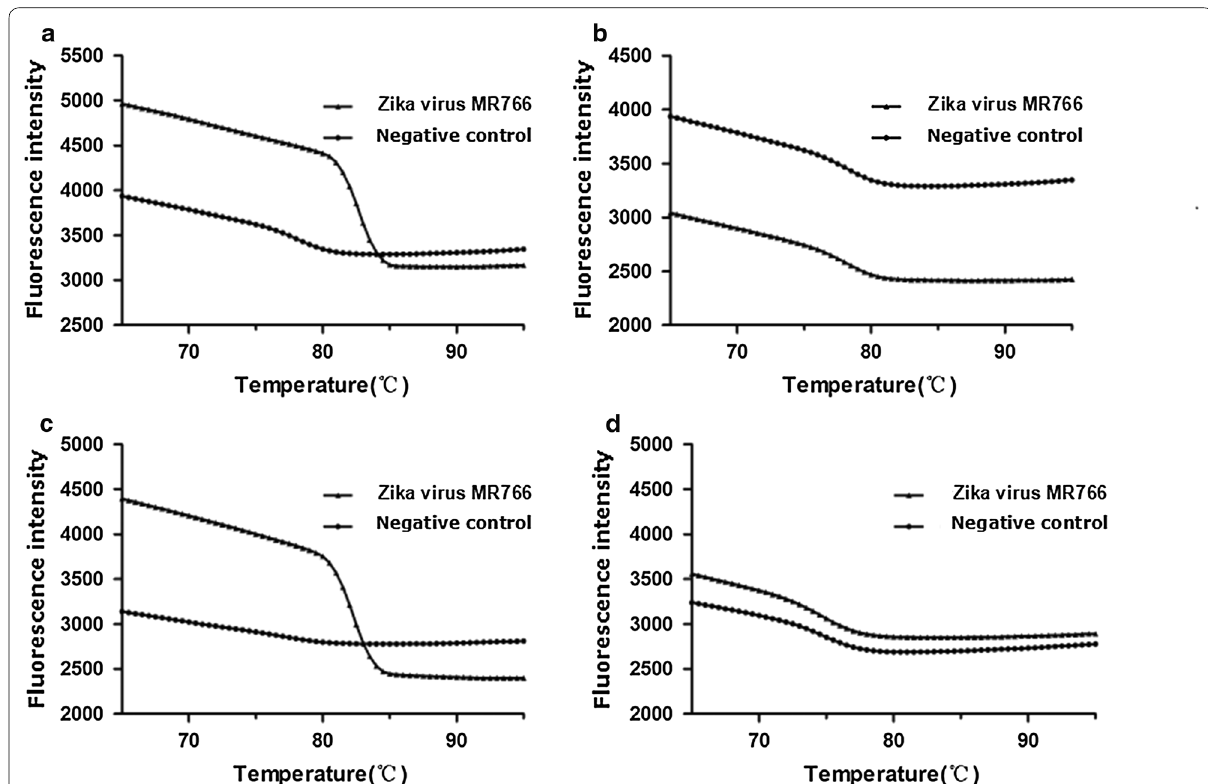
Fig. 2 The LAMP melting curve in this study: a real‑amp without loop primers (NS5‑1); b real‑amp without loop primers (NS5‑2); c real‑amp without loop primers (NS5‑3); d real‑amp without loop primers